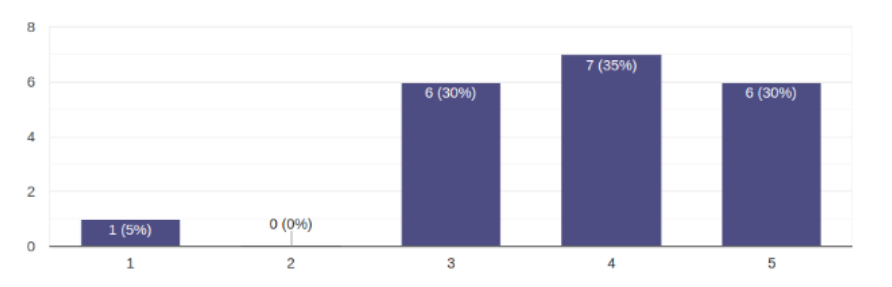
Figure 5. Answers regarding quality of the videos.